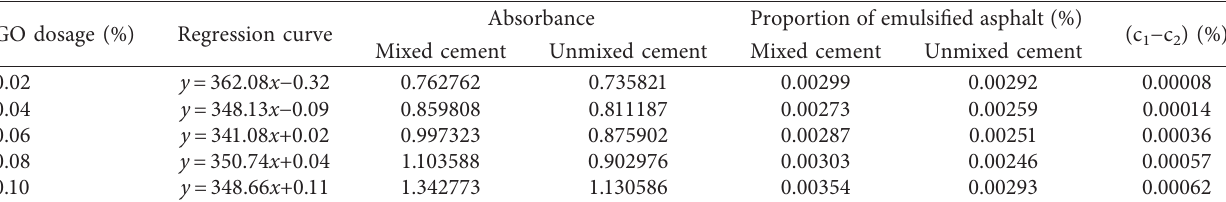
Figure 7: Absorbance results of CEAP with different emulsified asphalt Table 7: Effects of GO on absorption between cement and emulsified asphalt.